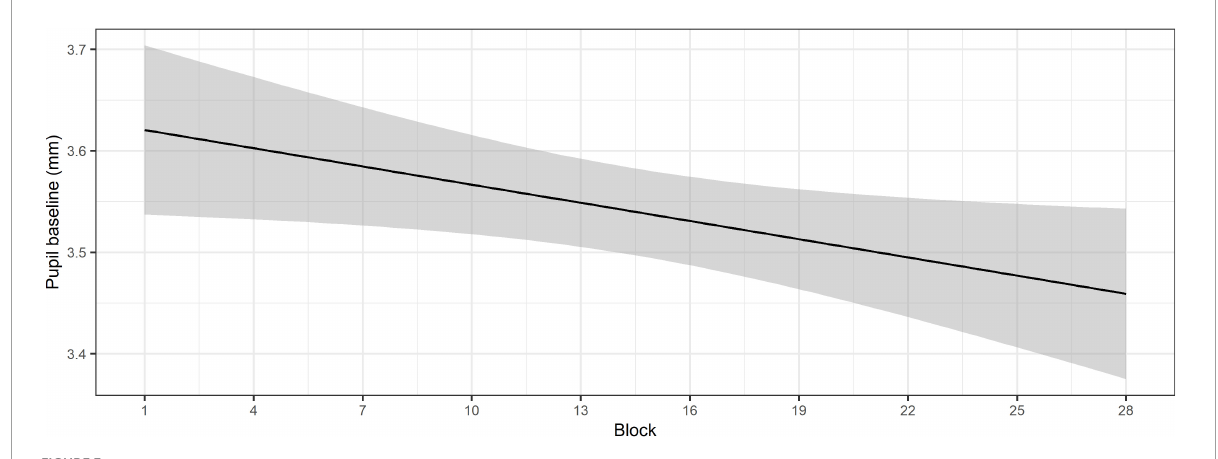
FIGURE3 Change in pupil baseline over the course of the SWIR test blocks. The shaded area shows the confidence intervals at the